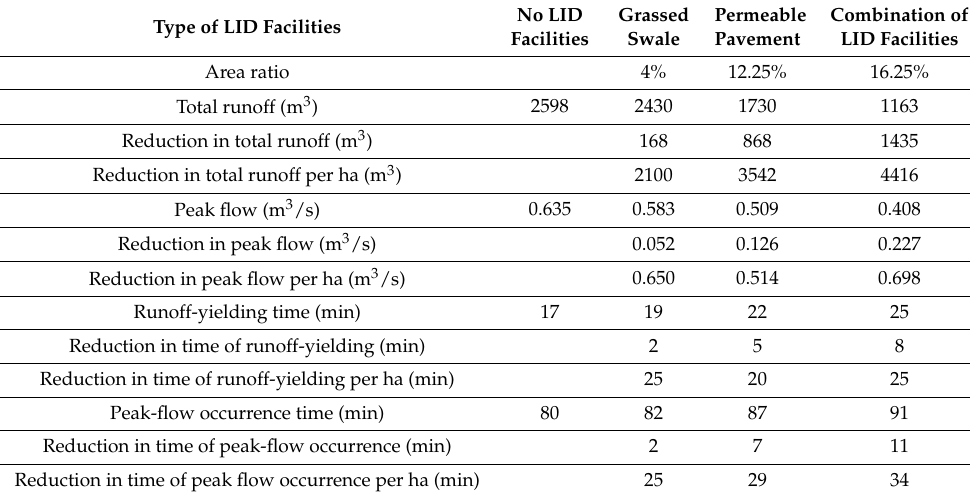
Table 4. Simulated results of runoff regulation effect